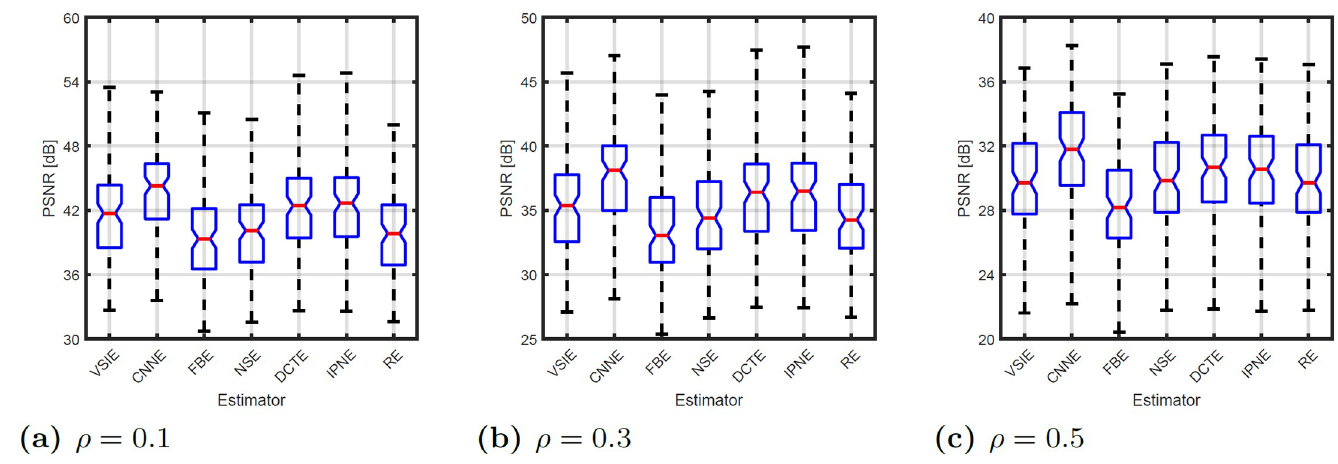
Fig 3. Impulse replacement performance using the best detector—CNND.